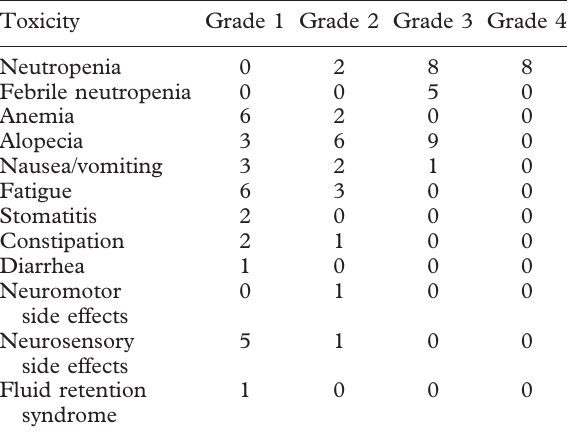
Table 2. Toxicity profile